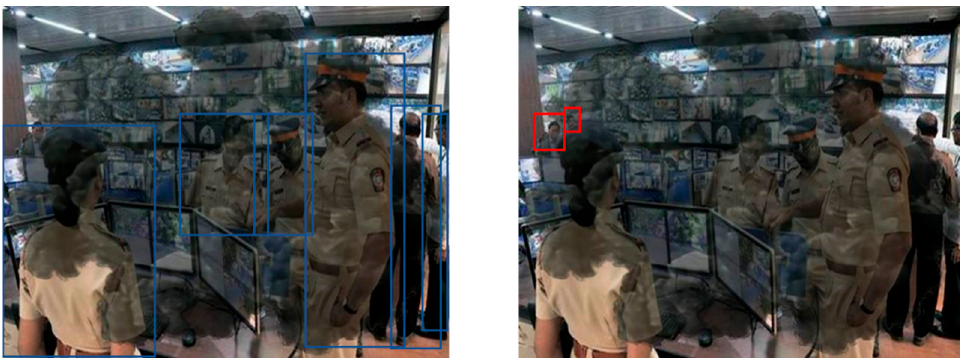
Figure 9. Results of classification to false negative. (YOLO)